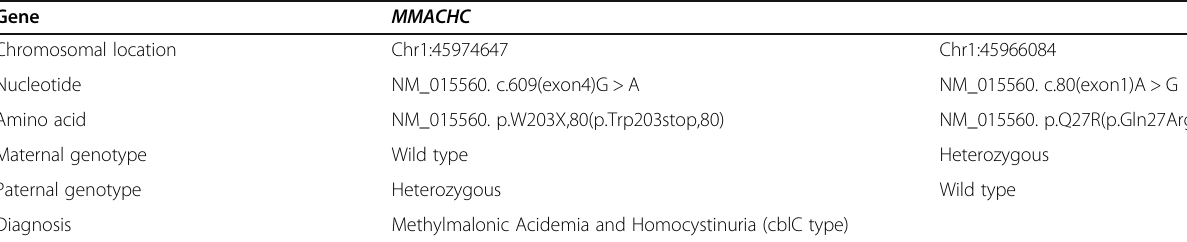
Table 1 Genetic testing of Case 1 and his